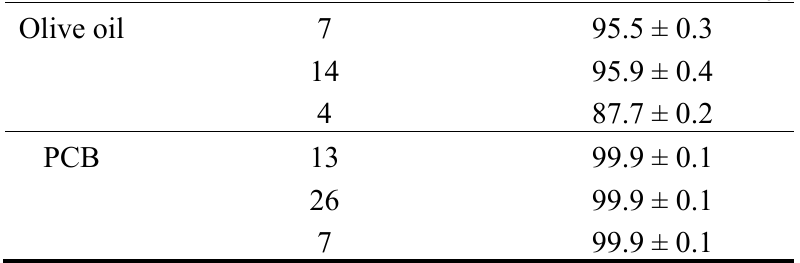
Table 1. Average prediction accuracies of the BNN models with 95% confidence intervals of Italian olive oil and the training set of the PCB data set. The BNN was trained by different number of hidden neurons with 30 BLPs.